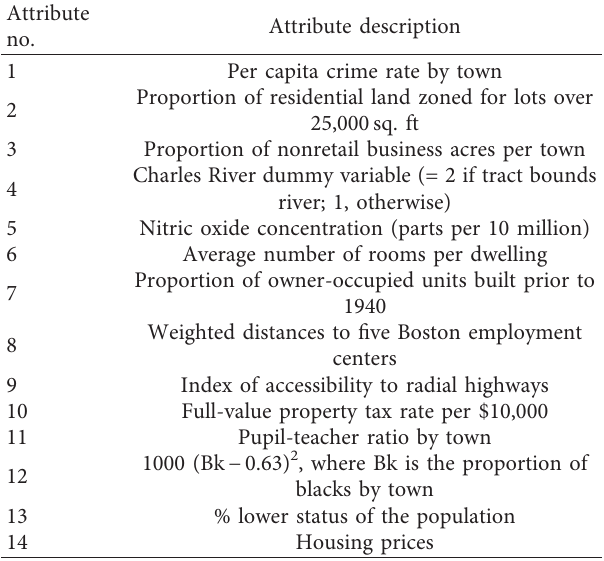
Table 4: Information on the attributes of the Boston housing dataset. Except attribute 4, all other attributes are continuous.